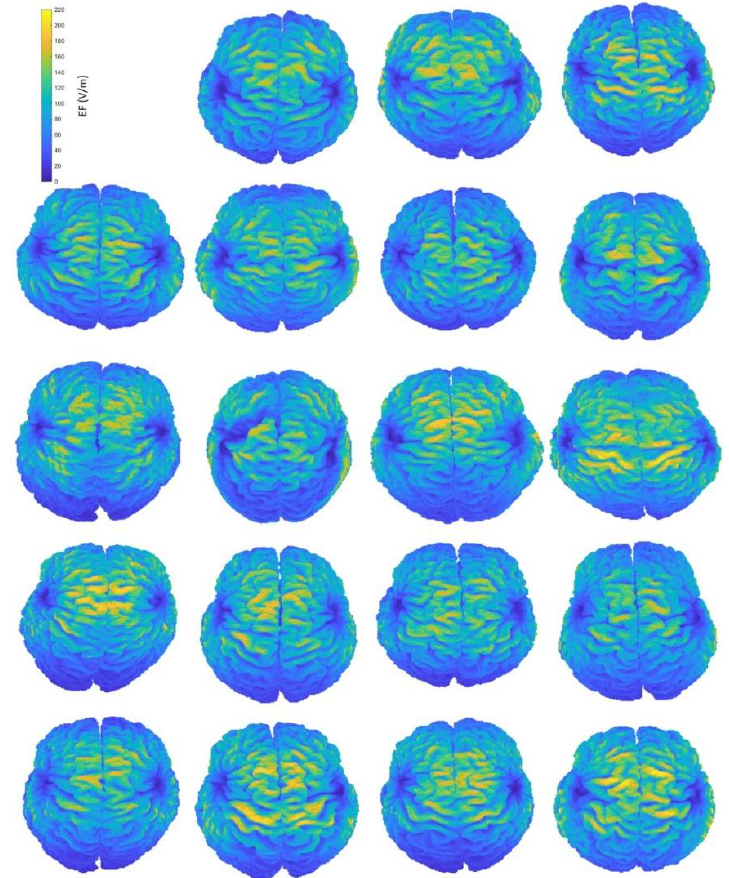
Figure 2. Interindividual variability of the induced EF distributions visualized in subject brains, containing both grey and white matter, when the H-coil is placed at the central position. Head and brain anatomy affect the area and magnitude of stimulation. Brain coordinates are plotted on their natural space.